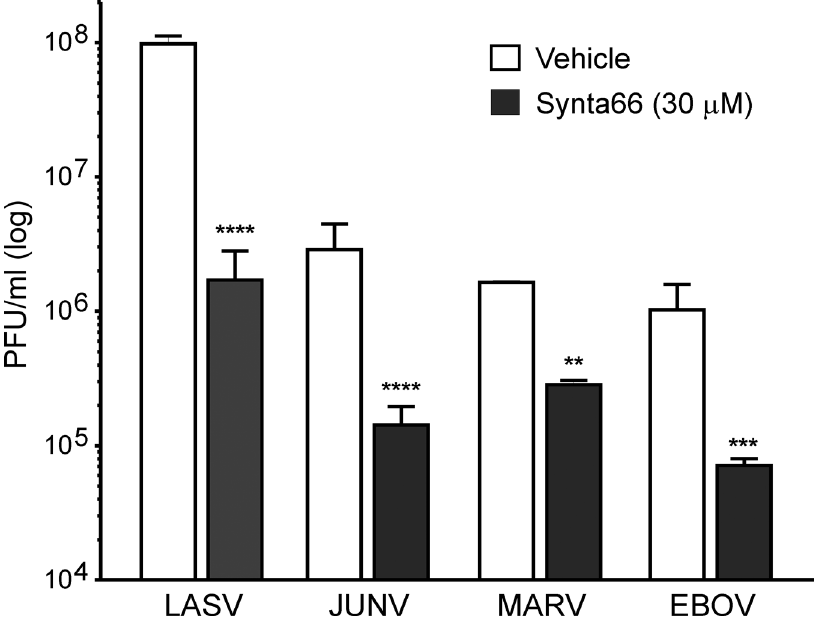
Fig 8. Synta66 decreases the number of viral particles in supernatants. A virus plaque assay used to quantify infectious virions in supernatants of virus infected cells demonstrates that Synta66 (30 μ M) significantly inhibits the budding and spread of live LASV, JUNV, MARV, and EBOV. Error bars indicate standard error of mean (SEM) and statistical significance was determined by two way ANOVA with Bonferroni multiple comparisons ( ** p < 0.01, *** p < 0.001, **** p <